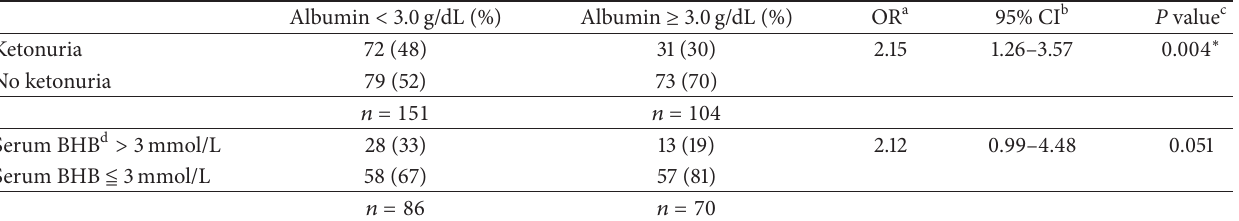
Table 2: Assessment of ketosis risk.